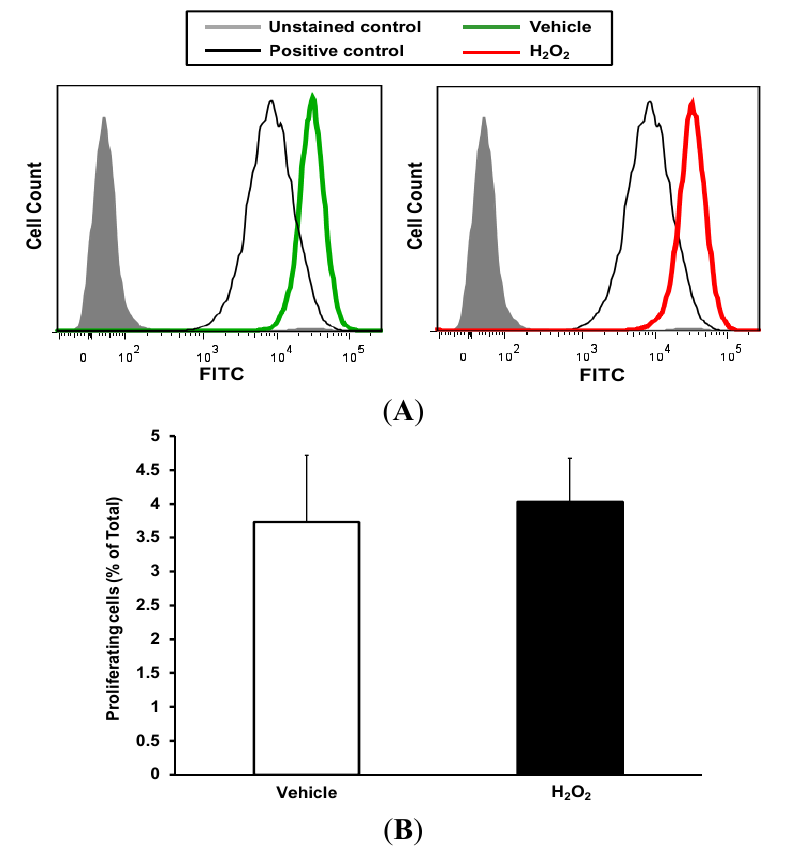
Figure 5. H O (50 µM) tyreatment for 24 h does not stimulate VSMC proliferation. 2 2 serum-starved (0.1% FBS, 24 h) VSMC were pretreated with CFSE (1.25 µM, 15 min) and incubated with vehicle or 50 µM H O . Twenty four hours later CFSE fluorescence was 2 2 evaluated using a BD LSRFortessa™ cell analyzer and flow data were analyzed using FlowJo (version 10). ( A ) Histograms showing CFSE fluorescence intensities in unstained controls (grey fill) and CFSE-stained VSMC treated with vehicle (green tracing) or H (red tracing). VSMC incubated for 48 h in the presence of complete growth media (10% fetal bovine serum; FBS) were used as positive controls (black tracing); ( B ) Quantitative assessment of VSMC proliferation ( n = 3). Data represent the mean ±